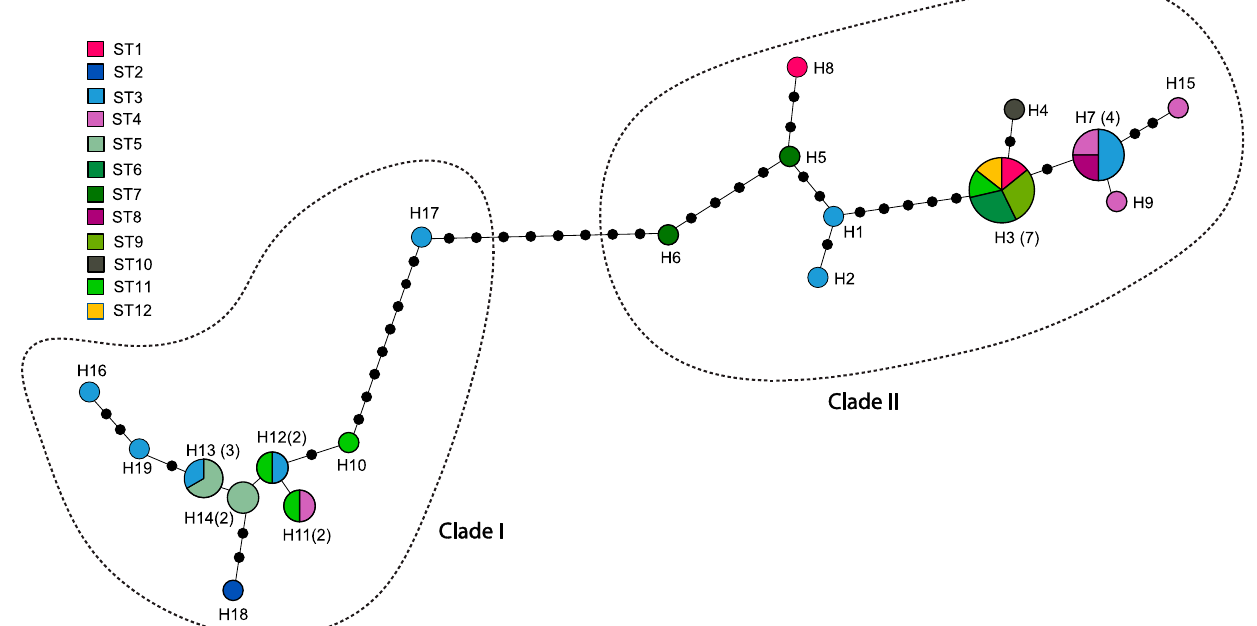
Figure 4. Haplotype network of COI sequences from C. relictus specimens from 12 localities. Each line represents a single mutational step, irrespective of length. Individual numbers of the respective haplotypes are presented in parentheses unless it was one individual.